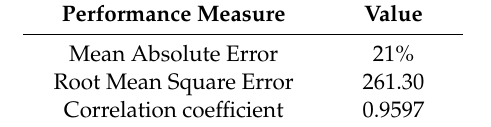
Table 8. Performance of the ANN model in predicting nitrous oxide fluxes for the datasets given in Table 7.